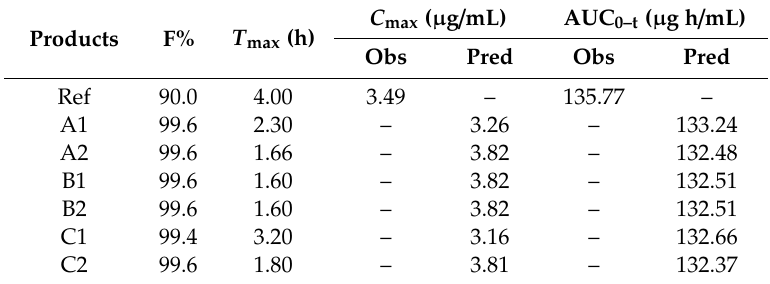
Table 5. Pharmacokinetic parameters of the reference product (Ref) based on the experimental curve and of products A1, A2, B1, B2, C1, and C2 obtained using simulated curves given by GastroPlus ™